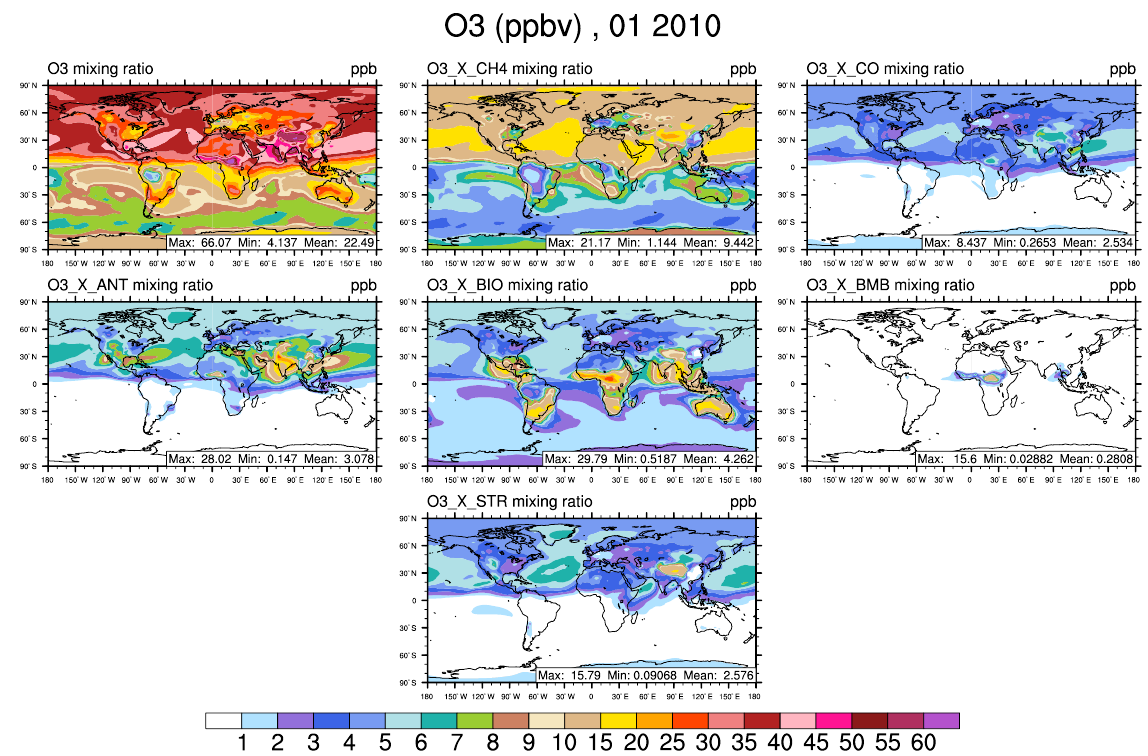
Figure 2. Surface ozone in January from the VOC-tagging run. Total surface ozone is shown in the top left panel. Other panels show the contribution to surface ozone due to methane (CH4), all CO emissions (CO), anthropogenic NMVOC sources (ANT), biogenic NMVOC sources (BIO), biomass burning NMVOC sources (BMB), and transport from the stratosphere